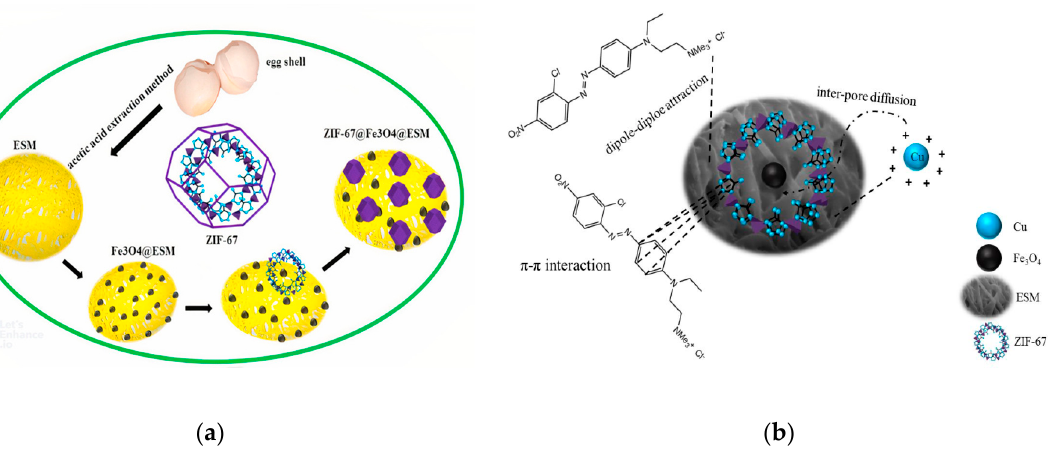
Figure 5. ( a ) Green synthesis of ZIF-67 @Fe 3 O 4 @ESM; ( b ) adsorption mechanism, reproduced with permission from [112]. Copyright Elsevier,